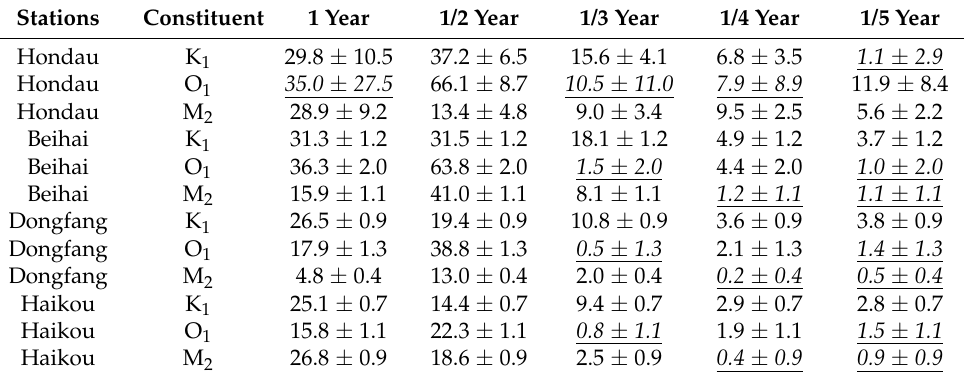
Table 5. The amplitudes and errors (unit: mm) of the seasonal and subseasonal cycles in tidal amplitudes at Hondau, Beihai, Dongfang and Haikou. Amplitude errors are obtained based on 95% confidence intervals [15]. Statistically insignificant results are labeled by